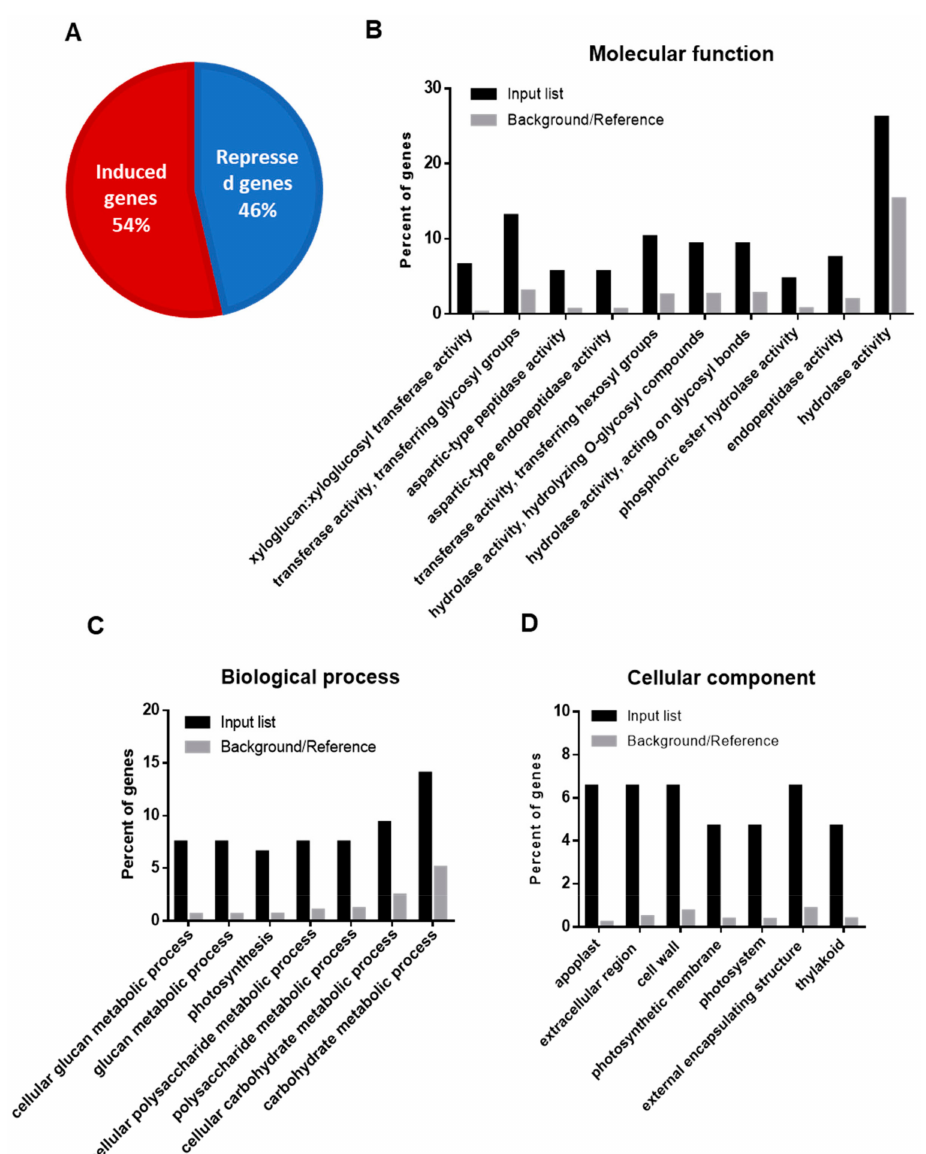
Figure 1. ( A ) Diagram showing percentage (%) of induced (red) and repressed genes (blue) in P. vulgaris leaves in response to drought. ( B ) Molecular functions, ( C ) biological process, and ( D ) cellular component gene ontology (GO) enrichment categorization of the di ff erentially expressed genes in RNA-seq analysis using the AgriGOv2.0 software (http: // bioinfo.cau.edu.cn / agriGO / )